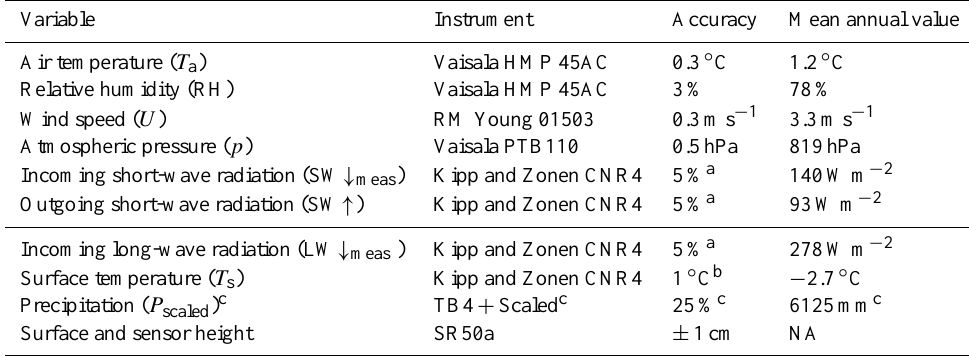
Table 1. Variables measured, sensor specifications, and mean annual values at AWS glacier during the study period. Variable